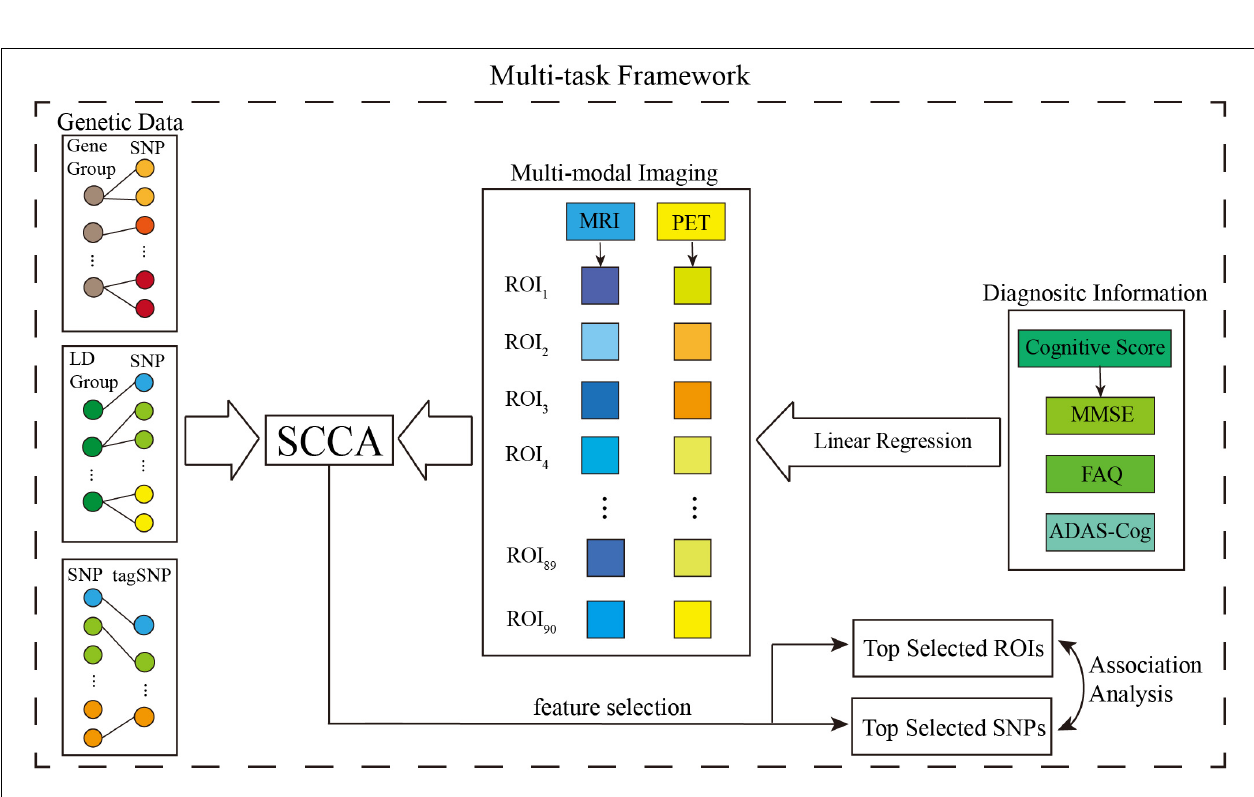
FIGURE 2 | Schematic illustration of